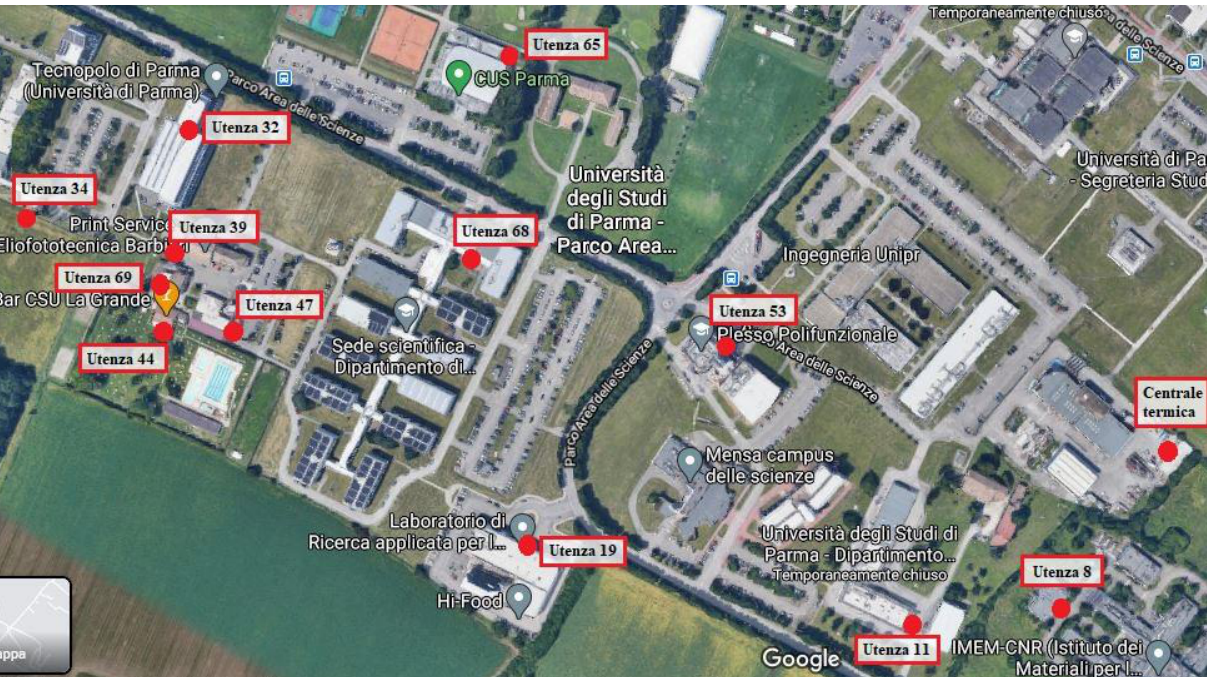
Figure 1. Parma Campus–Users (“Utenza”) supplied by the “Nuova Sud” network, Source: Google Maps.